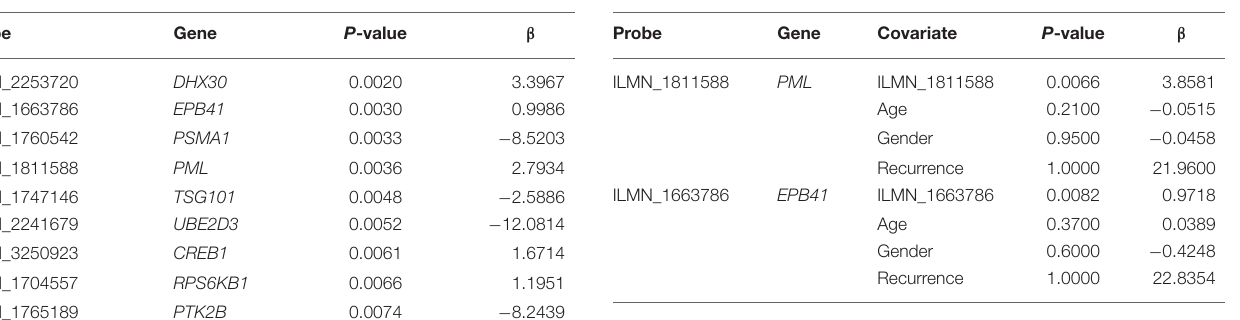
TABLE 3 | Result of univariate Cox regression analysis. TABLE 4 | Result of multivariate Cox regression